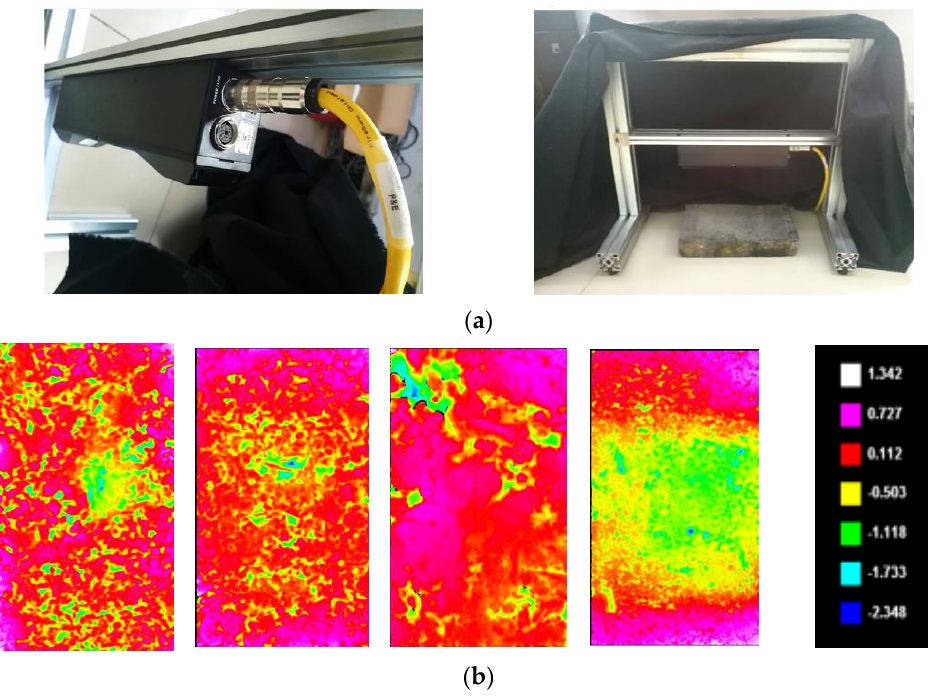
Figure 3. Surface texture 3D point cloud data collection. ( a ) 3D data acquisition equipment construc- tion. ( b ) Pseudo color map of texture depth data.